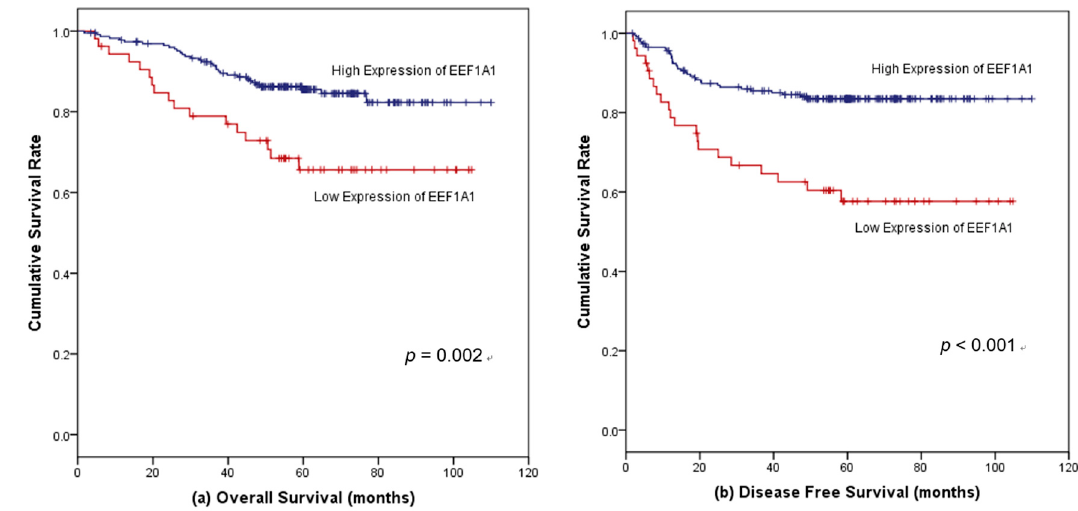
Figure 3. Kaplan–Meier survival curves according to EEF1A1 protein expression in all colon cancer patients. ( a ) High EEF1A1 expression was significantly associated with favorable overall survival (OS) and ( b ) disease-free survival (DFS).